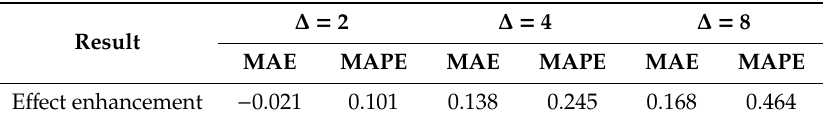
Table 2. Result of data set